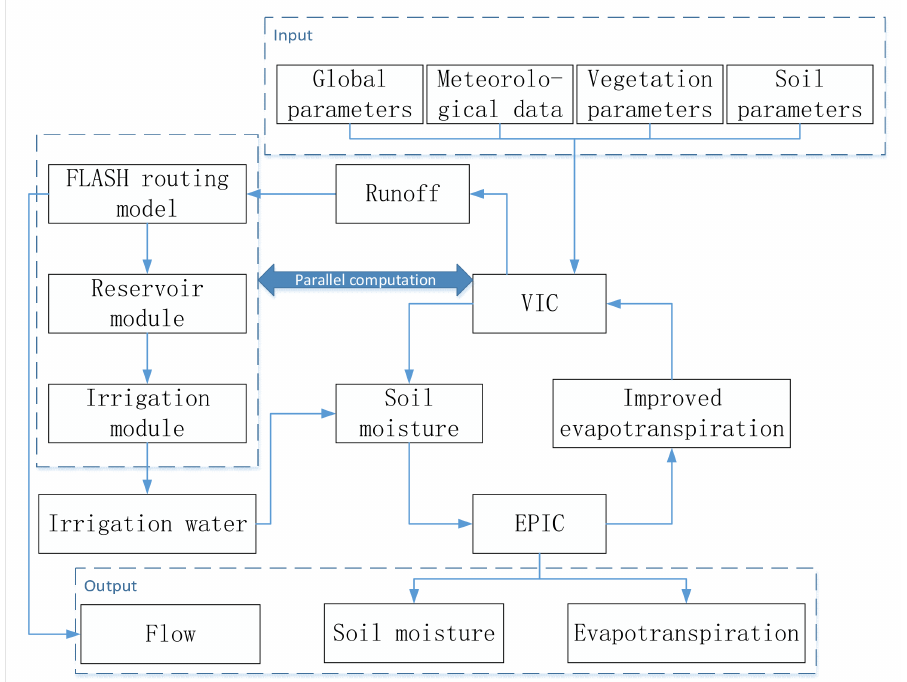
Figure 1. Flowchart of the coupled VIC-EPIC model integrated using FLASH and the reservoir